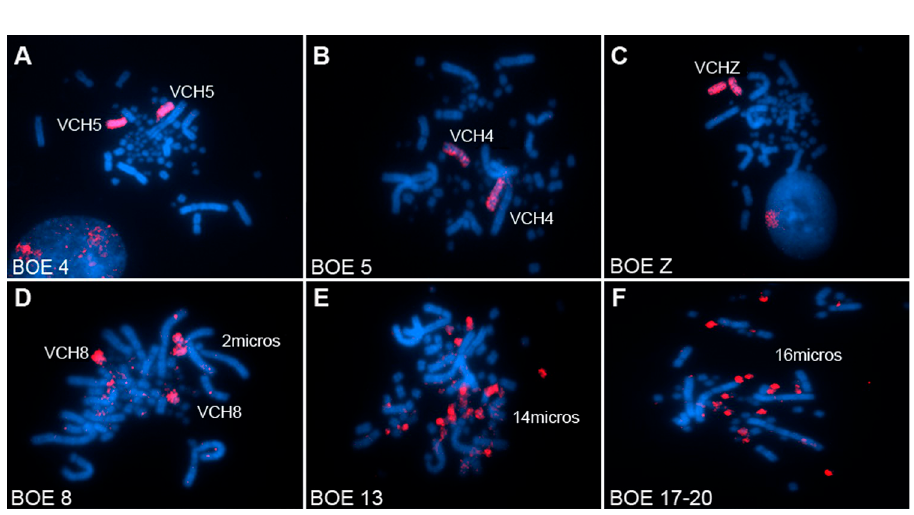
Fig 5. Chromosomal painting of whole chromosome probes of Burhinus oedicnemus homologous to macrochromosomes in Vanellus chilensis . The probes are visualized with avidin-Cy3 (red); chromosomes counter- stained with DAPI